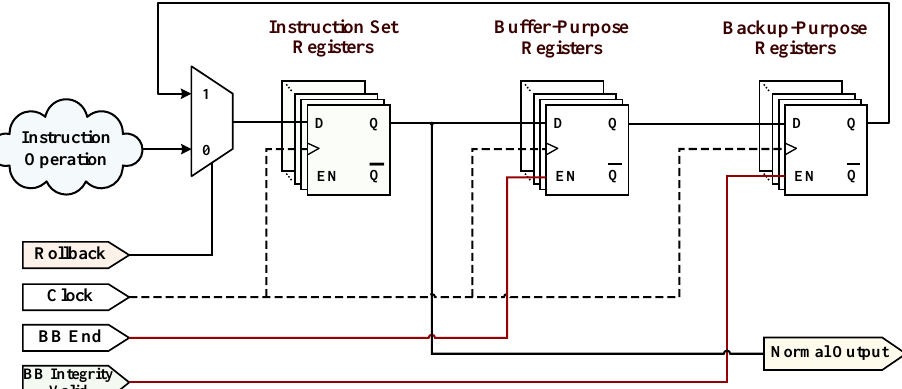
Figure 4. The schematic implementation of two-stage registers for checkpoint-rollback